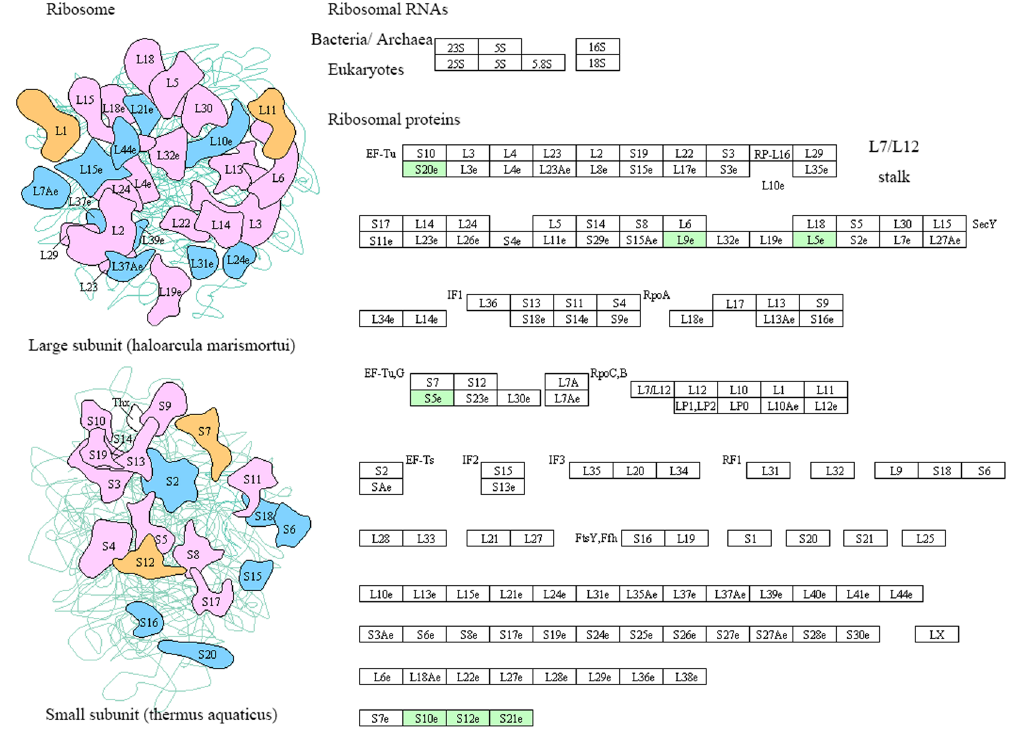
Figure 4. Ribosome pathway obtained from KEGG pathway analysis. The protein names in green color are differentially regulated by melatonin under salt stress during seed